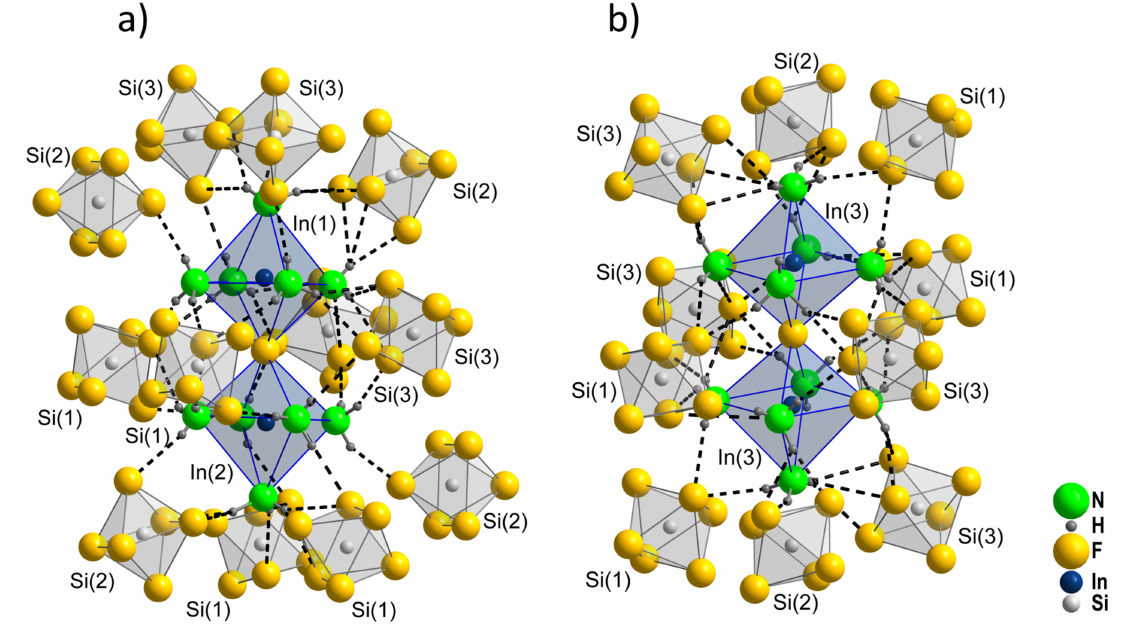
Figure 9. Interconnection of ( a ) the [(NH 3 ) 5 In(1)–F–In(2)(NH 3 ) 5 ] 5+ octahedra double via hydrogen bonds to 12 [SiF 6 ] 2 − octahedra and ( b ) the [(NH 3 ) 5 In(3)–F–In(3)(NH 3 ) 5 ] 5+ octahedra double via hydrogen bonds to 10 [SiF 6 ] 2 −